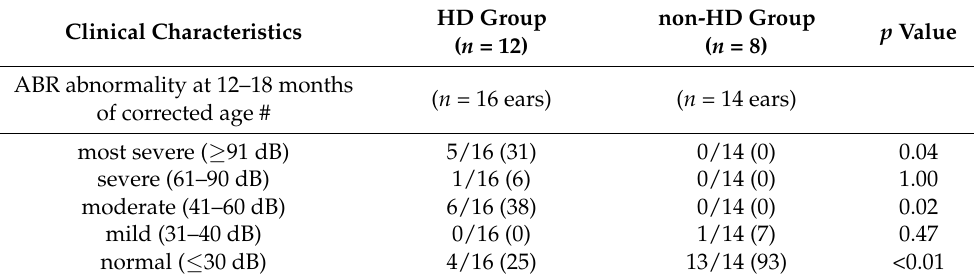
ABR, auditory brainstem response. $ Data were not available for 2 infants in HD group. # Data were not available for 4 infants in HD group and 1 infant in non-HD group.